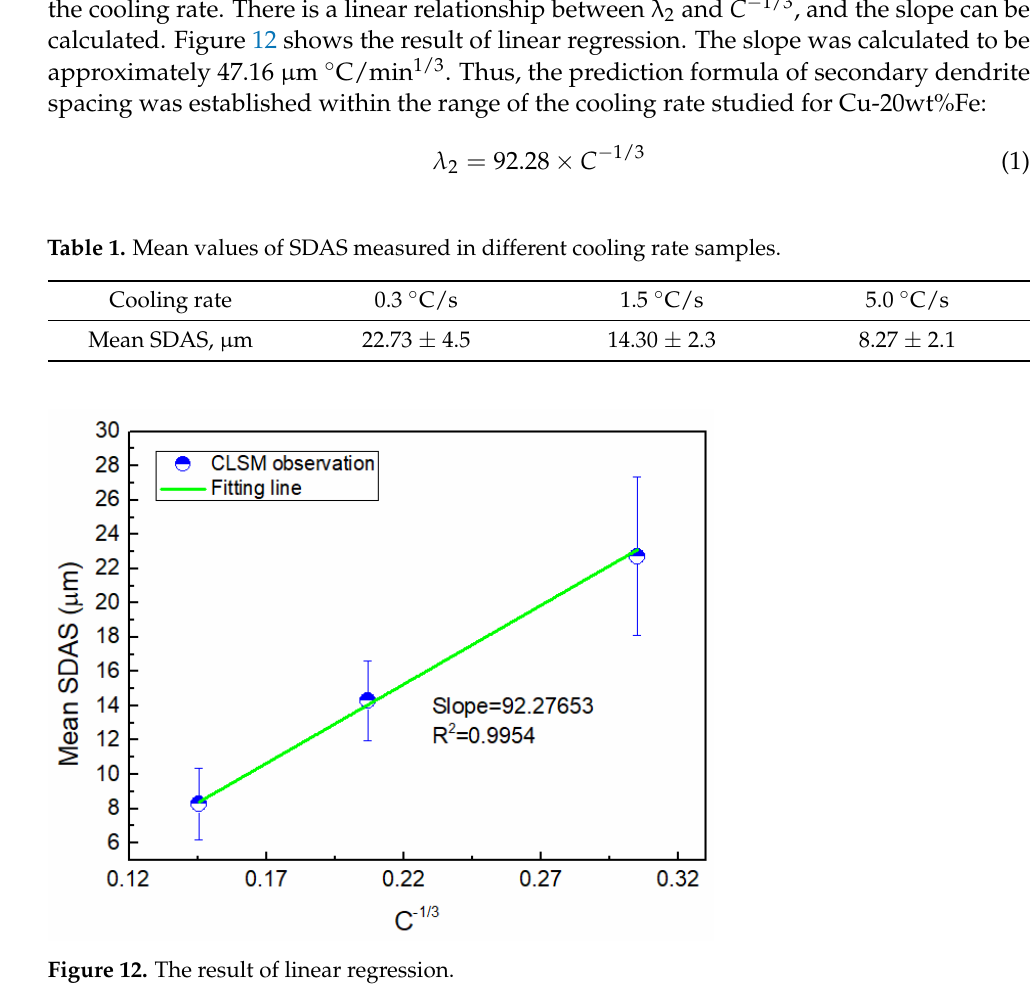
Figure 12. The result of linear regression.